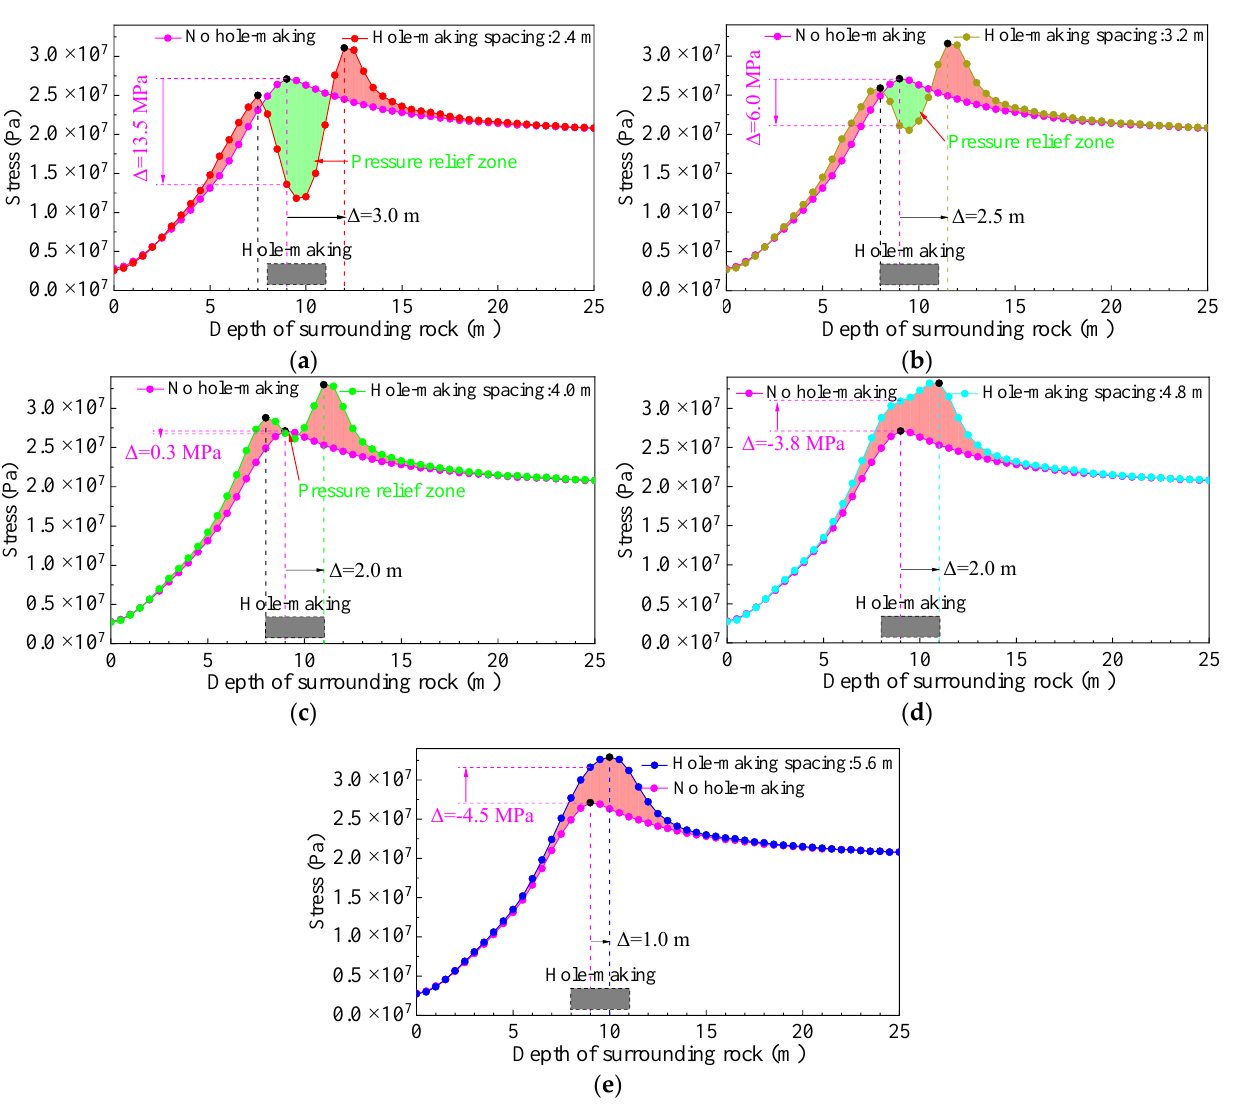
Figure 12. Comparison diagram of the roadway rib stress curve at different vales of hole-making spacing. ( a ) Hole − making spacing = 2.4 m; ( b ) Hole − making spacing = 3.2 m; ( c ) Hole − making spacing = 4.0 m; ( d ) Hole − making spacing = 4.8 m; ( e ) Hole − making spacing = 5.6 m.